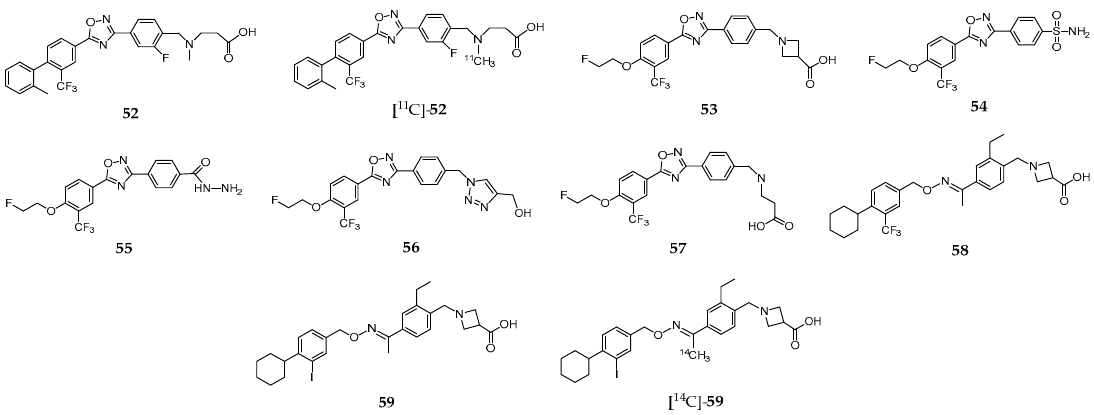
Figure 7. S1PR ligands based on the trifluoromethyl phenyl-oxadiazole scaffold.